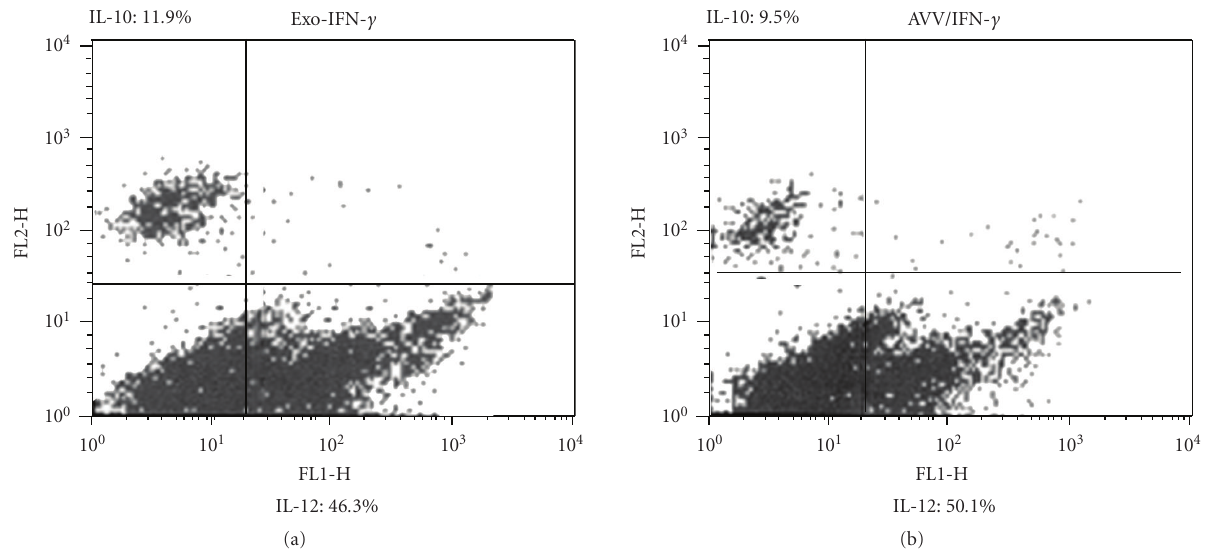
Figure 5: IL-12 and IL-10 expression in DC Analysis of IL-12 and IL-10 expression in DC under treatment with exogenous IFN- γ treatment versus AAV/IFN- γ transduction. Note that the IL-12/IL-10 ratio was slightly enhanced by AAV/IFN- γ transduction.